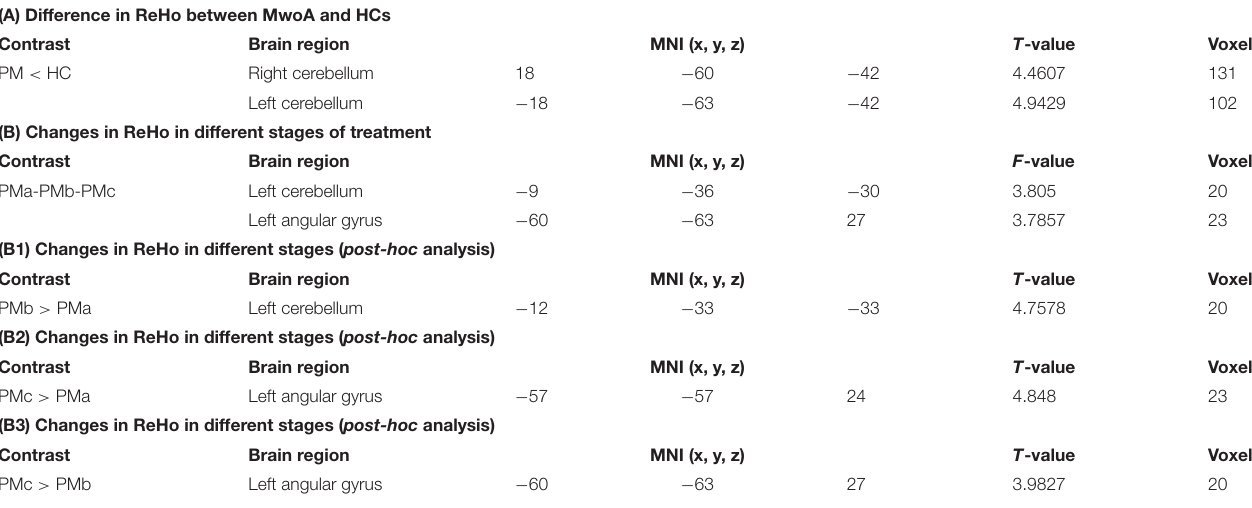
TABLE 3 | Changes in regional homogeneity in patients with migraine without aura and healthy controls during the study period. (A) Difference in ReHo between MwoA and HCs Brain region MNI (x, y, z) T -value Voxels Right cerebellum